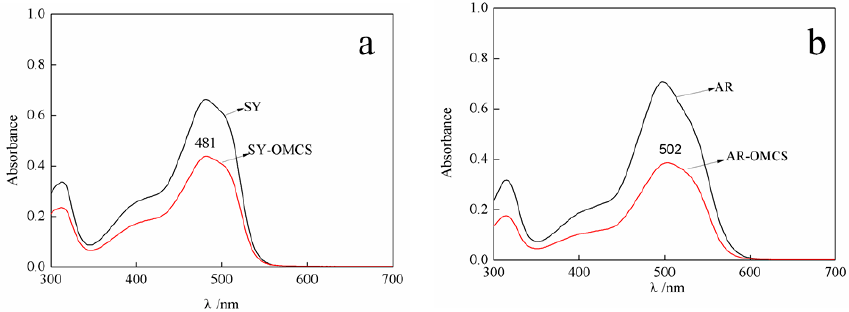
Figure 4. UV-vis spectra of prepared polymer dyes and the original azo dyes. ( a ) SY and SY-OMCS; ( b ) AR and AR-OMCS.